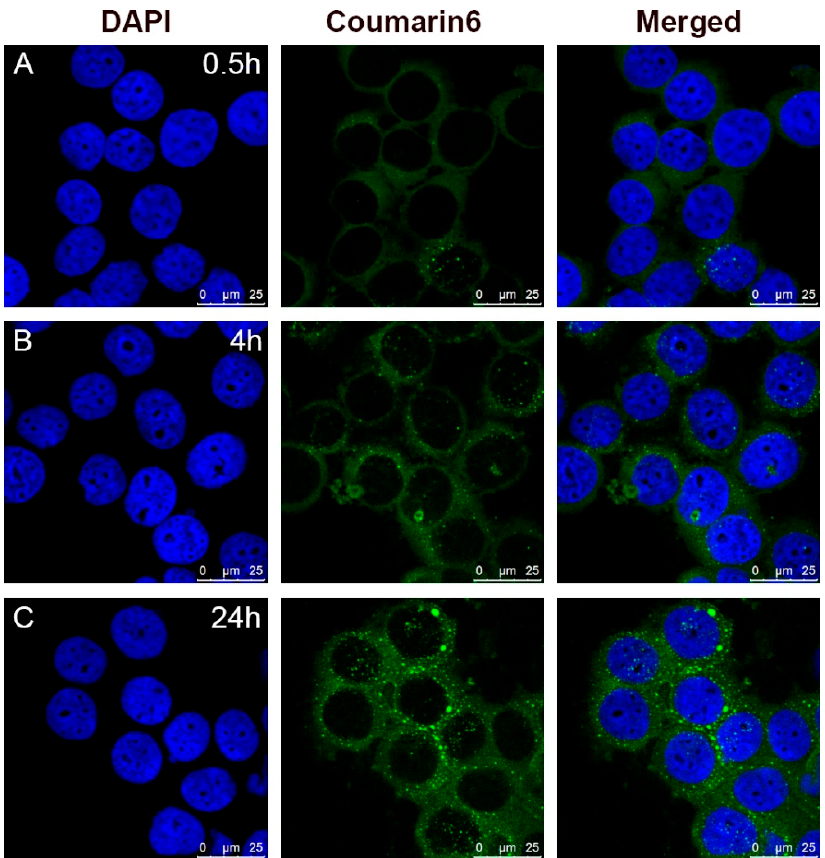
Figure 10. Confocal laser scanning microscopy (CLSM) images of HeLa cells incubated with coumarin-6 labeled drug loaded micelles after ( A ) 0.5 h, ( B ) 4 h and ( C ) 24 h.